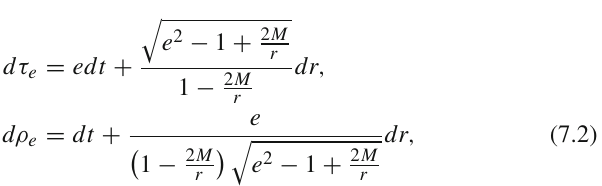
figurationofphysicalfieldsandthevectorfield ξ